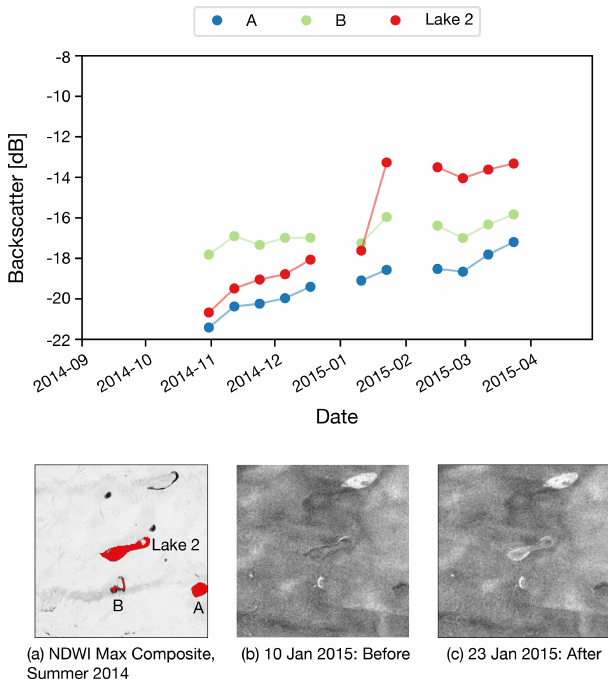
Figure D2. Lake 2 surrounding lakes.